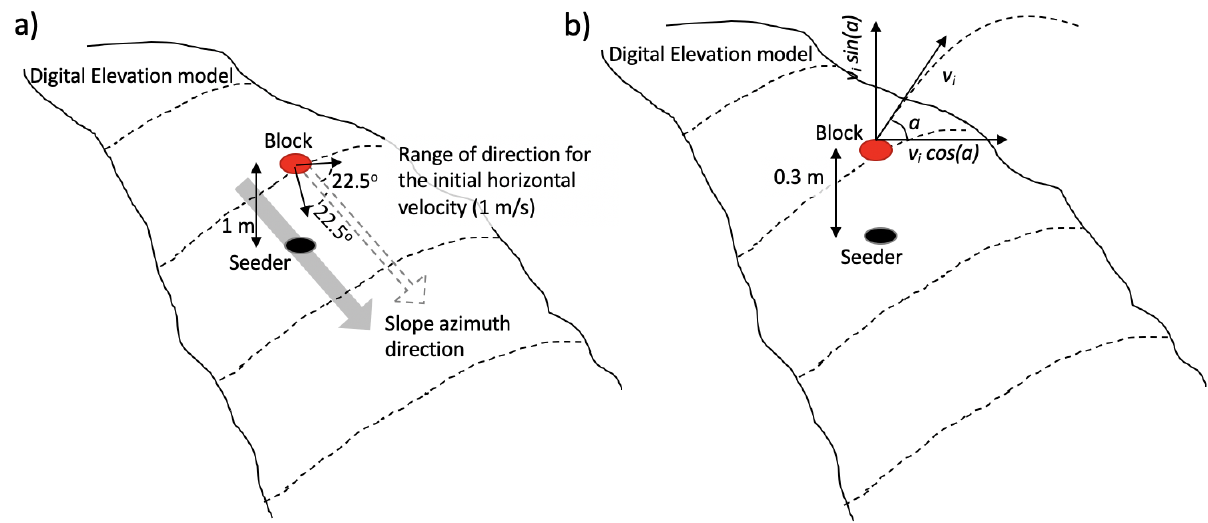
Figure 4. Initial height and velocities for trajectory models of originated from natural block detachment ( a ) and as flyrock ( b ). Not to scale.